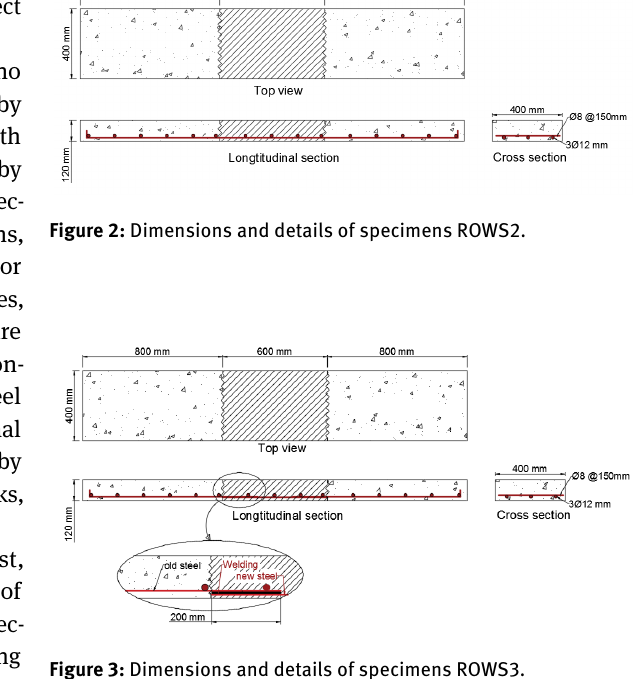
Figure 3: Dimensions and details of specimens ROWS3.